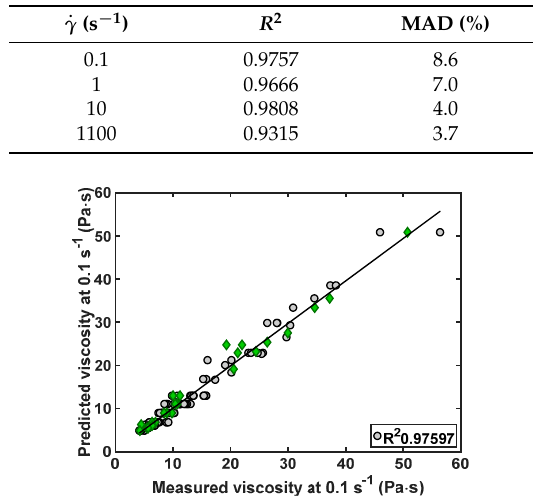
Table 2. Performance of the neural network.